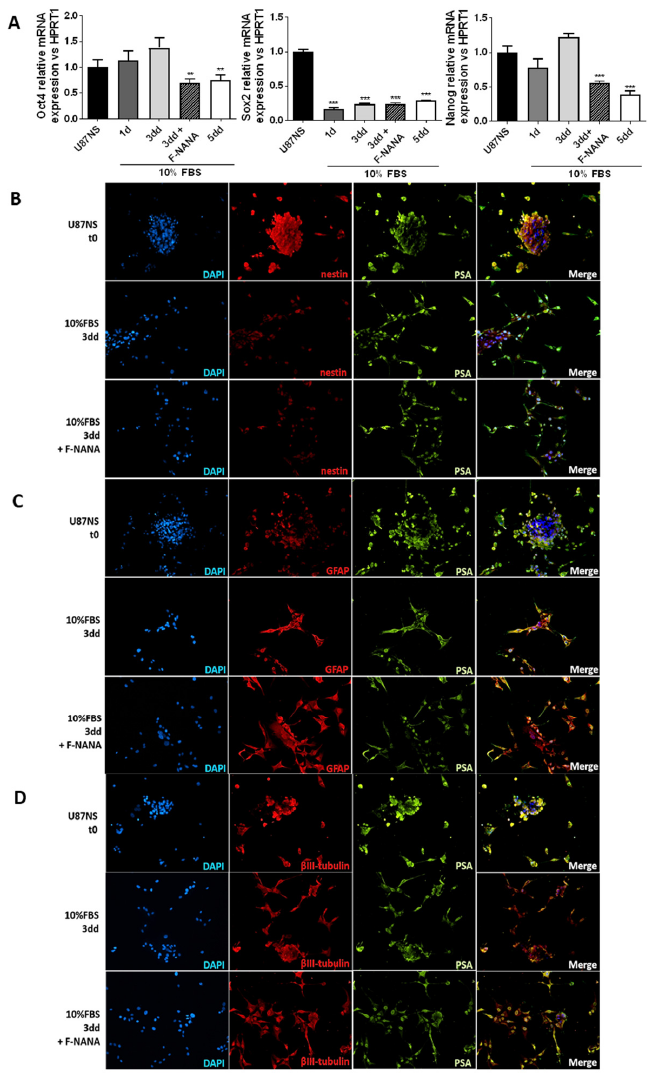
Figure 7. Effect of PSA inhibition on U87NS cell differentiation. ( A ) Real-time PCR analysis showing mRNA expression of the stemness genes Oct-4, Sox-2 and Nanog in U87NS cells differentiated for 5 days in medium supplemented with 10% FBS. The condition of differentiating U87NS cells treated with 100 μ M F-NANA for 3 days is also reported. Results are presented as the mean ± SD of three independent experiments. **: p < 0.01; ***: p < 0.001. ( B – D ) Immunofluorescence analysis showing the co-expression (Merge) of PSA (in green) with the stemness marker Nestin (red) or the differentiation markers GFAP and β III-tubulin (in red) in U87NS cells, differentiated or not for 3 days in medium supplemented with 10%FBS, treated or not with 100 μ M F-NANA. Nuclei were counterstained with DAPI (in blue). 1d: day 1; 3dd: day 3; 5dd: day 5.